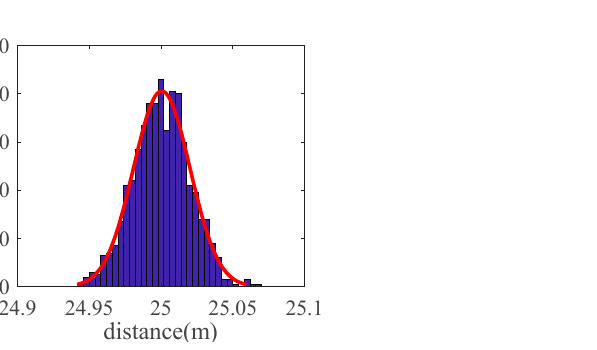
Figure 4. Ranging error obeys normal distribution.